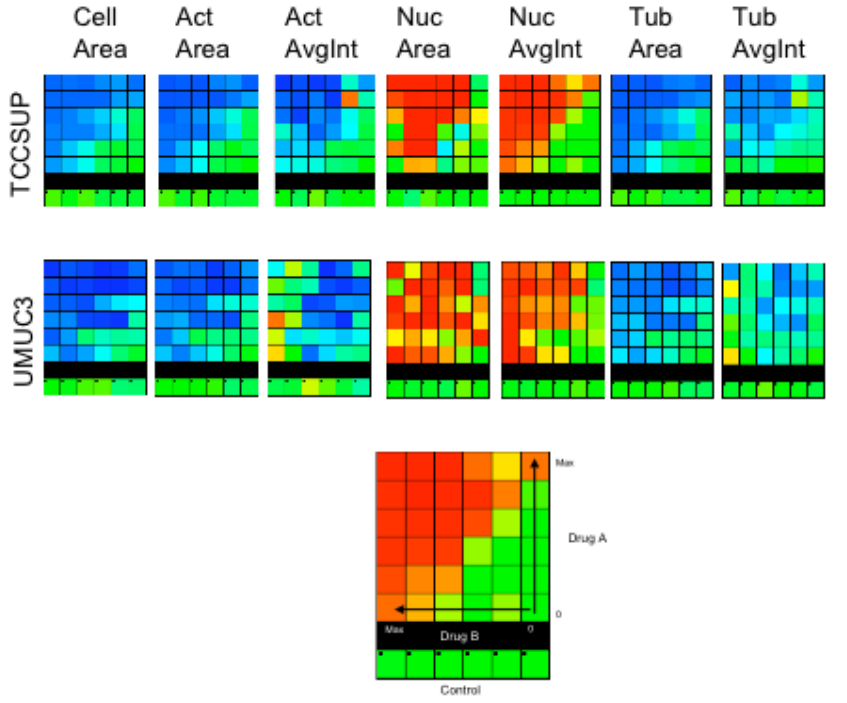
Figure 4. Drug combination essays. The combinations were selected from 20 “responsive” drugs (Table 1). 16 two-drug combinations matrices were applied to two cell lines (TCCSUP & UMUC3). 5x5 matrices (10x5 wells including duplicates) + single-drug rows and columns + controls were prepared. 4 dual combinations were set in each plate, 8 plates total (4 for each cell line). Example of 7 single features response for the combination of Radicinin (rows) and Brasilin (columns) in concentrations of 4-0.25µM are displayed for the two cell lines (TOP). The data require preparation of larger matrices with more dilutions and repeats. Nevertheless we attempted to fit the Mahalanobis scores (BOTTOM) to Loewe or Bliss models (see Methods) but found no significant